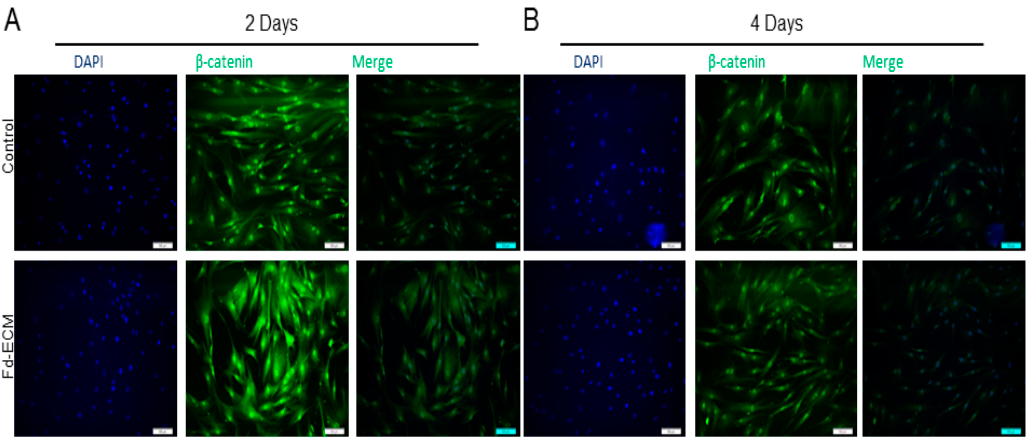
Figure 8. Cont. Figure 8. Cont.